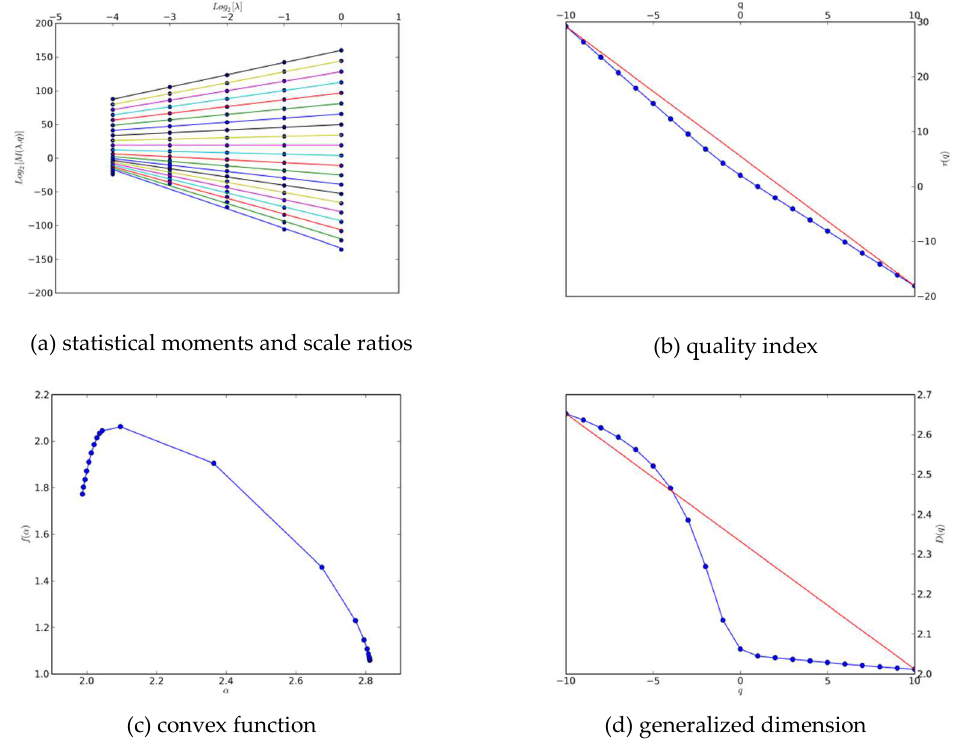
Figure 7. Multifractal characteristics verification in homogenized precipitation fields in July 2016. ( a ) statistical moments and scale ratios, ( b ) quality index, ( c ) convex function, ( d ) generalized di- mension.